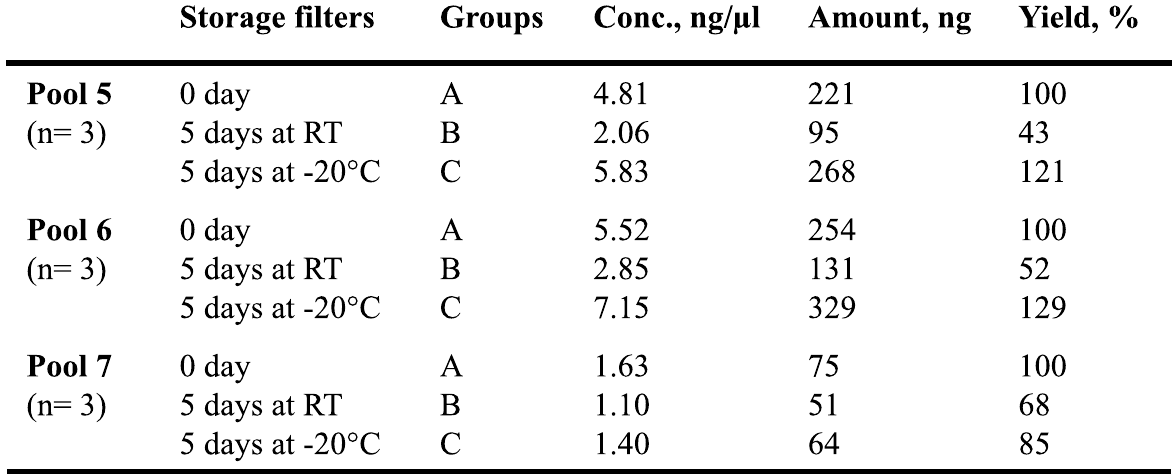
Table 2 Relationship between filter storage conditions, concentration and amount of urine